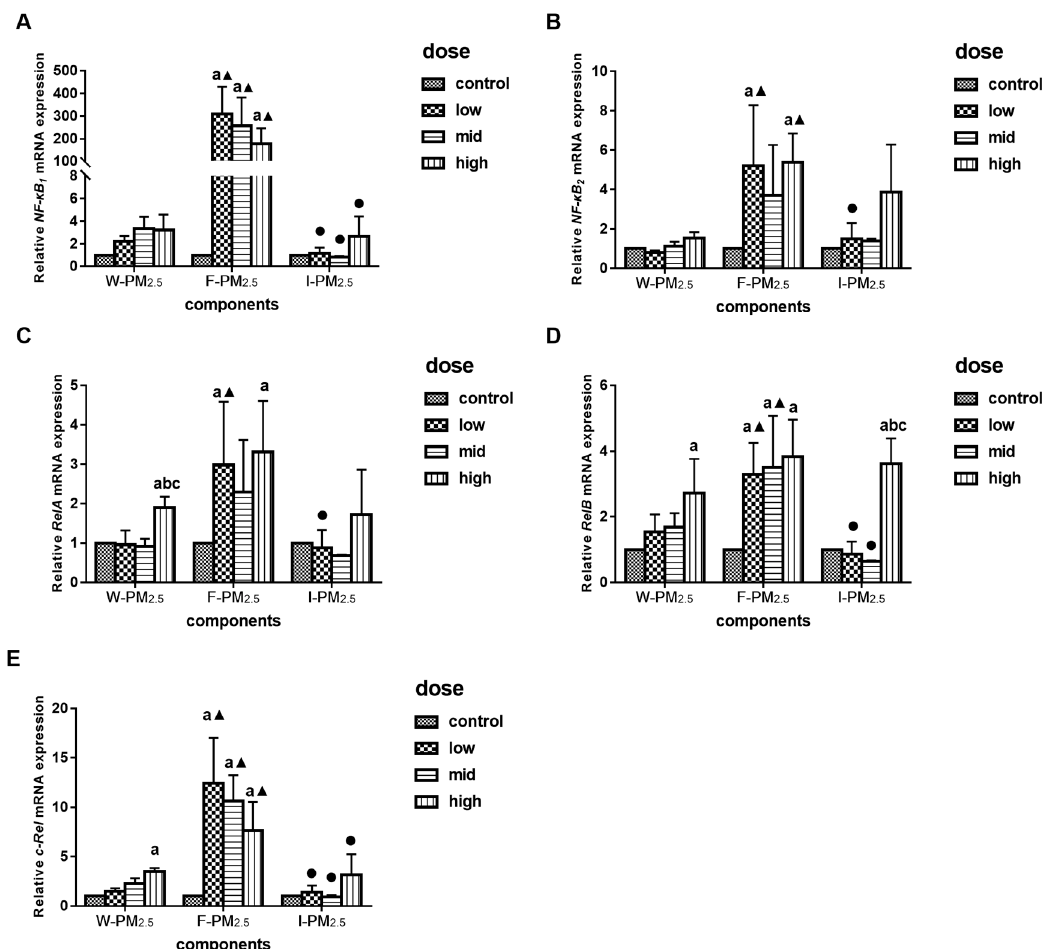
Figure 5. Effects of PM 2.5 on the relative mRNA expression levels of NF- κ B 1 ( A ), NF- κ B 2 ( B ), RelA ( C ), RelB ( D ), and c- Rel ( E ). Data are presented as means ± SD of three independent vs. control group; b p < 0.05 vs. low-dose group; c p < 0.05 vs. mid-dose group; (cid:78) p < 0.05 vs. W-PM 2.5 at the same dose; (cid:8) p < 0.05 vs. F-PM 2.5 at the same experiments. a p < 0.05 vs. control group; b p < 0.05 vs. low-dose group; c p < 0.05 vs. mid- dose group; ▲ p < 0.05 vs. W-PM 2.5 at the same dose; ● p < 0.05 vs. F-PM 2.5 at the same dose.